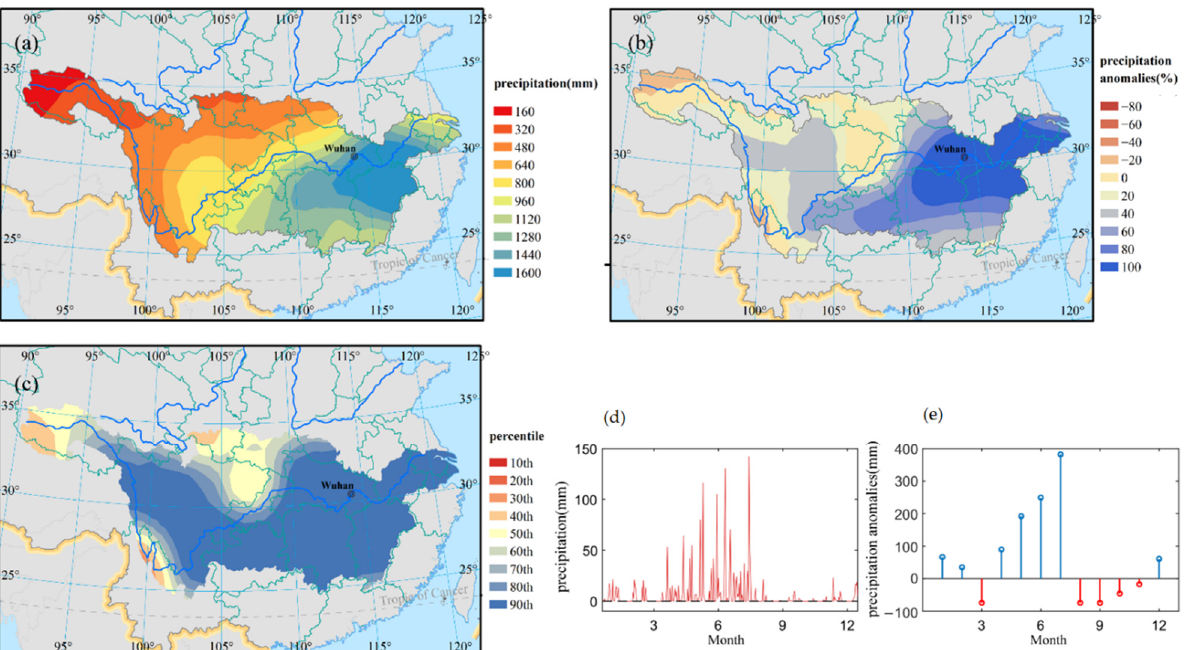
Figure 1. ( a ) Precipitation across the Yangtze River valley during April–July of 1954; ( b ) rainfall anomaly rates across the Yangtze River valley during April–July of 1954; ( c ) precipitation percentile across the Yangtze River valley during April–July of 1954—the 90th percentile indicates that the precipitation in that year exceeded 90% of the years from 1951 to 1980—which can be used as the threshold of extreme precipitation events; ( d ) daily precipitation in Wuhan in 1954; ( e ) monthly precipitation anomalies in Wuhan in 1954. The data used in the figures are ground station precipi- tation data from 1951 to 1980. We converted the ground station data into contours based on the kriging method.